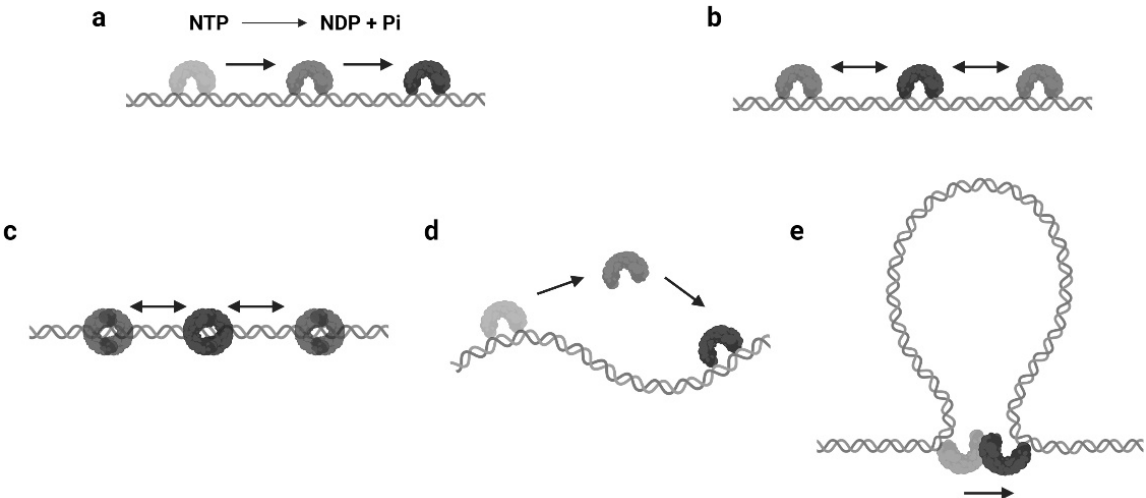
Figure 1. Modes of protein 1D sliding. ( a ) Translocation: protein moves along DNA in a unidirectional way by NTP hydrolysis (NDP: nucleoside diphosphate, Pi: inorganic phosphate). ( b ) Facilitated diffusion: protein passively slides on DNA to search targets after nonspecific binding. ( c ) Sliding as a clamp: ring-like protein passively slides on DNA with intermittent DNA contacts. ( d ) Hopping or jumping: protein diffuses on DNA with a series of disassociation and rebinding events. ( e ) Intersegment transfer: protein moves from one binding site to another via the formation of a transient DNA loop. The double helix structures represent dsDNA and the arch or ring-like structures represent DNA-binding proteins. The black arrows indicate the directions of protein movements on DNA.